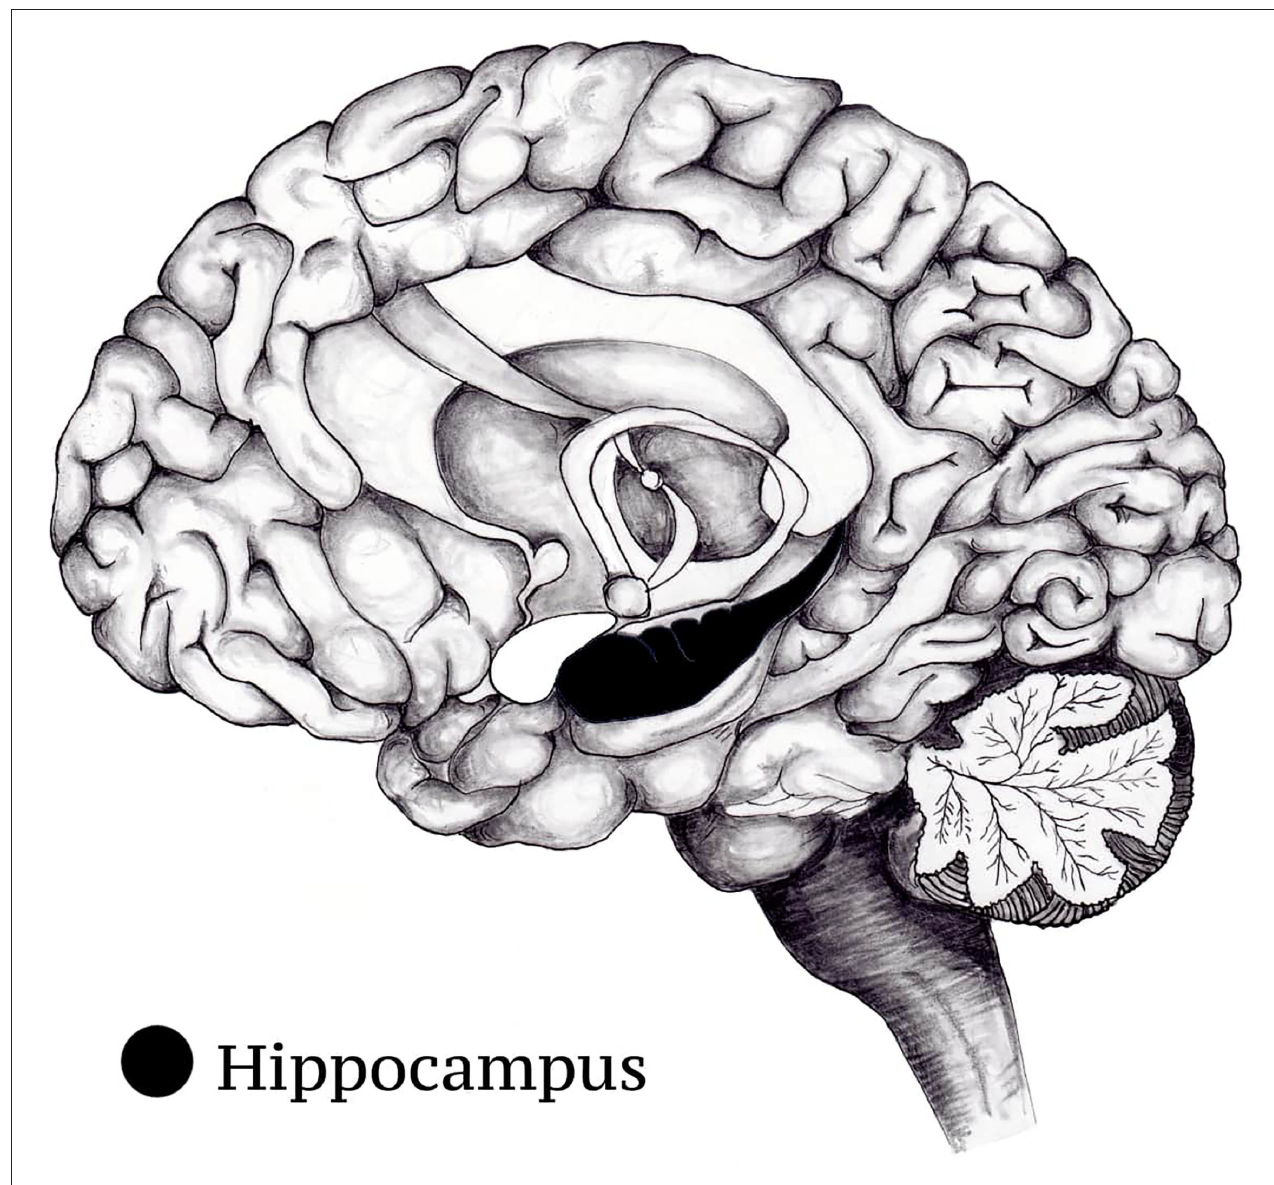
FIGURE 3 | Location of the